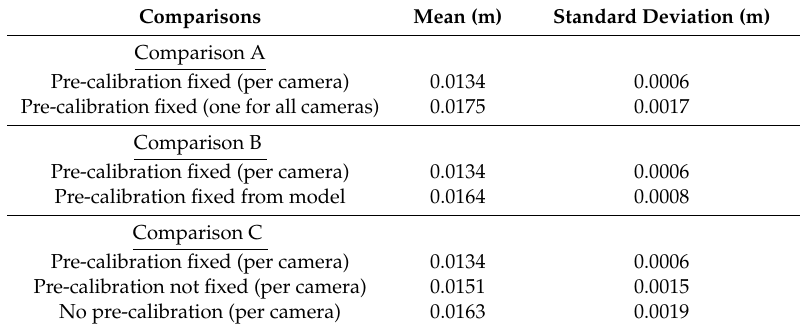
Table 1. Summary statistics of three time series comparisons.